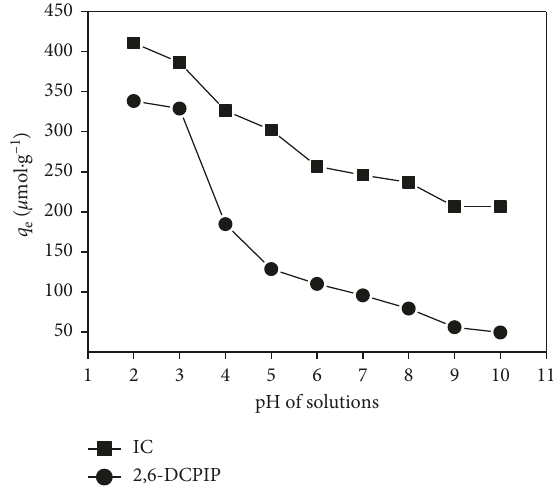
Figure 10: Effectof solution pHon the ICand 2,6-DCPIPadsorption. Experimental conditions: [IC] � [2,6-DCPIP] � 5 × 10 − 5 mol · L − 1 ; m � 0.133g · L − 1 ; G � 0–100 μ m; t � 40min for IC; t � 30minfor 2,6-DCPIP; v � 150rpm; V � 30mL; at room temperature.